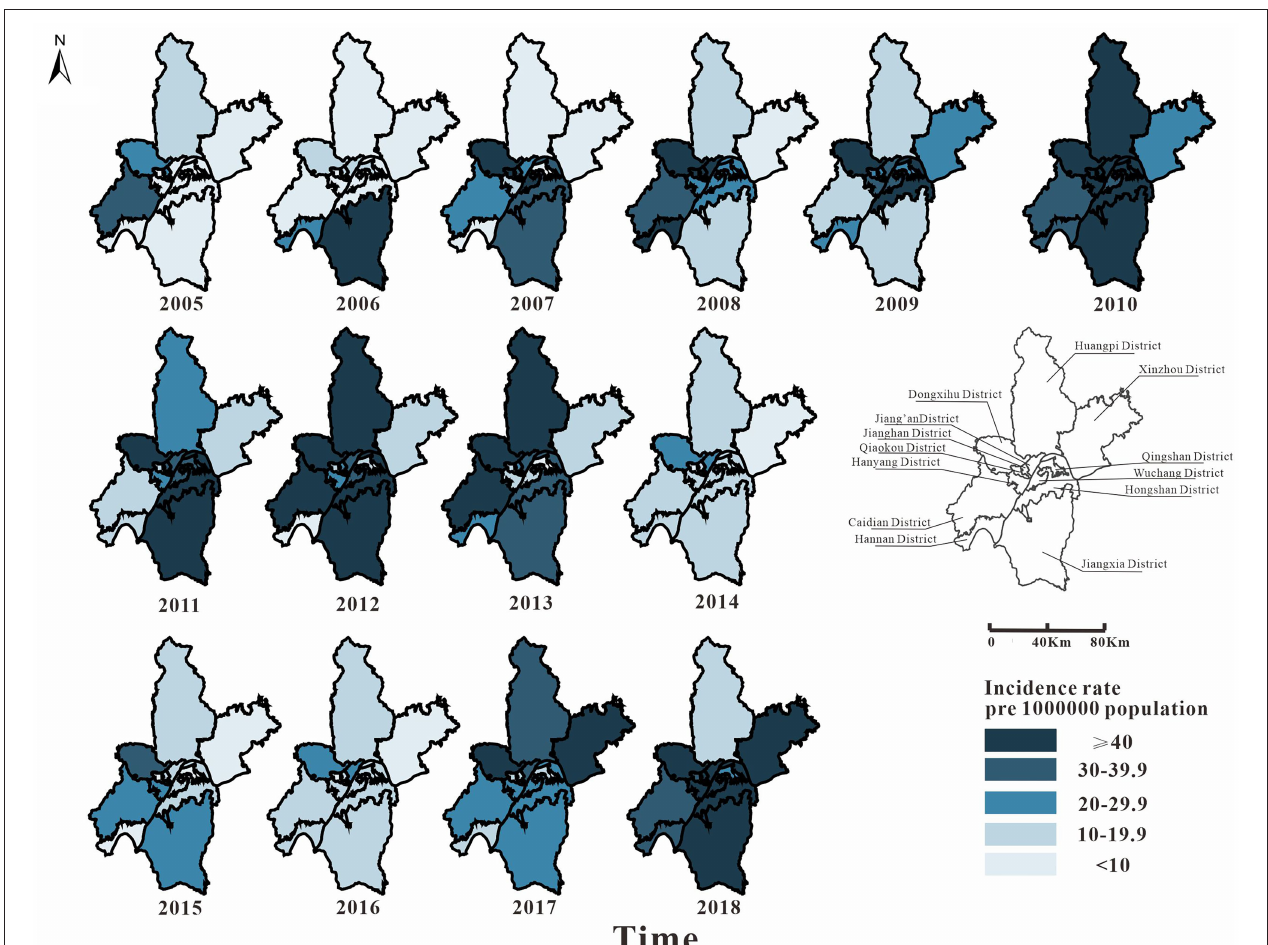
FIGURE 3 | Map of the incidence rate of mumps in Wuhan City in 2005–2018. The map depicted in this figure was taken from Wikimedia Commons (http:// commons.wikimedia.org/wiki/Main_Page).